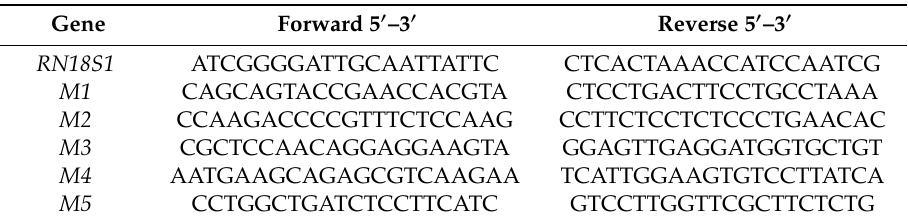
Table 1. List of RT-PCR